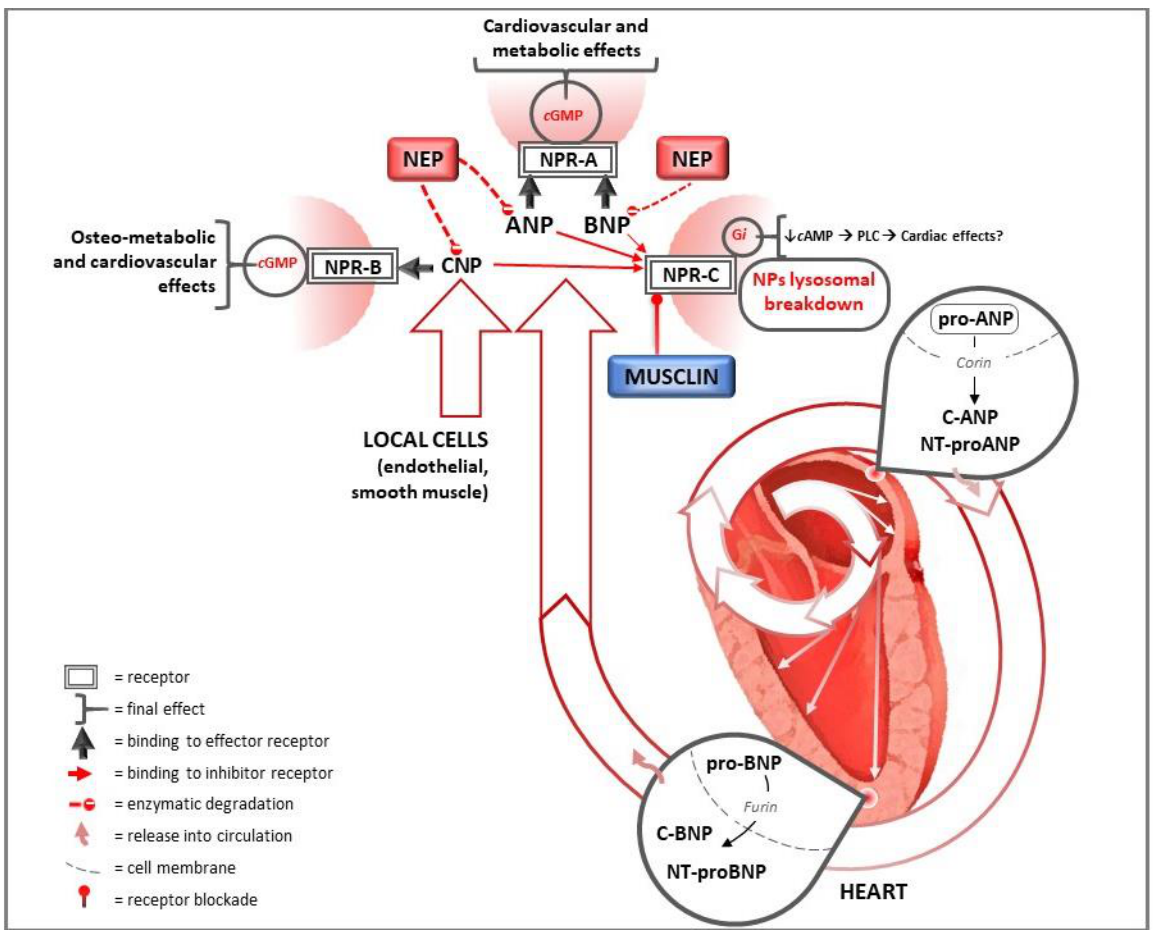
Figure 2. Natriuretic peptides pathways for heart and cardiovascular protection. ANP and BNP are synthesized in response to wall hemodynamic stress as precursor proteins in the heart and subsequently released into circulation after cleavage in their active form. CNP is mainly produced by endothelial cells. They exert several cardiac and systemic effects on the target organs, including the heart, binding to NPR-A and NPR-B. Their degradation is mediated by binding to NPR-C and by neprilysin. In this context, musclin competitively binds NPR-C, inhibiting NPR-C-mediated NPs degradation. Nep: neprilysin; ANP: atrial natriuretic peptide; BNP: B-type natriuretic peptide; CNP: C-type natriuretic peptide; NT: N terminal; NPR-A: natriuretic peptide receptor A; NPR-B: natriuretic peptide receptor B; NPR-C: natriuretic peptide receptor C; cGMP: cyclic guanosine monophosphate; cAMP: cyclic adenosine monophosphate; Gi: inhibitory G protein; PLC: phospholipase C. Supplementary Materials: The supporting information can be downloaded at: